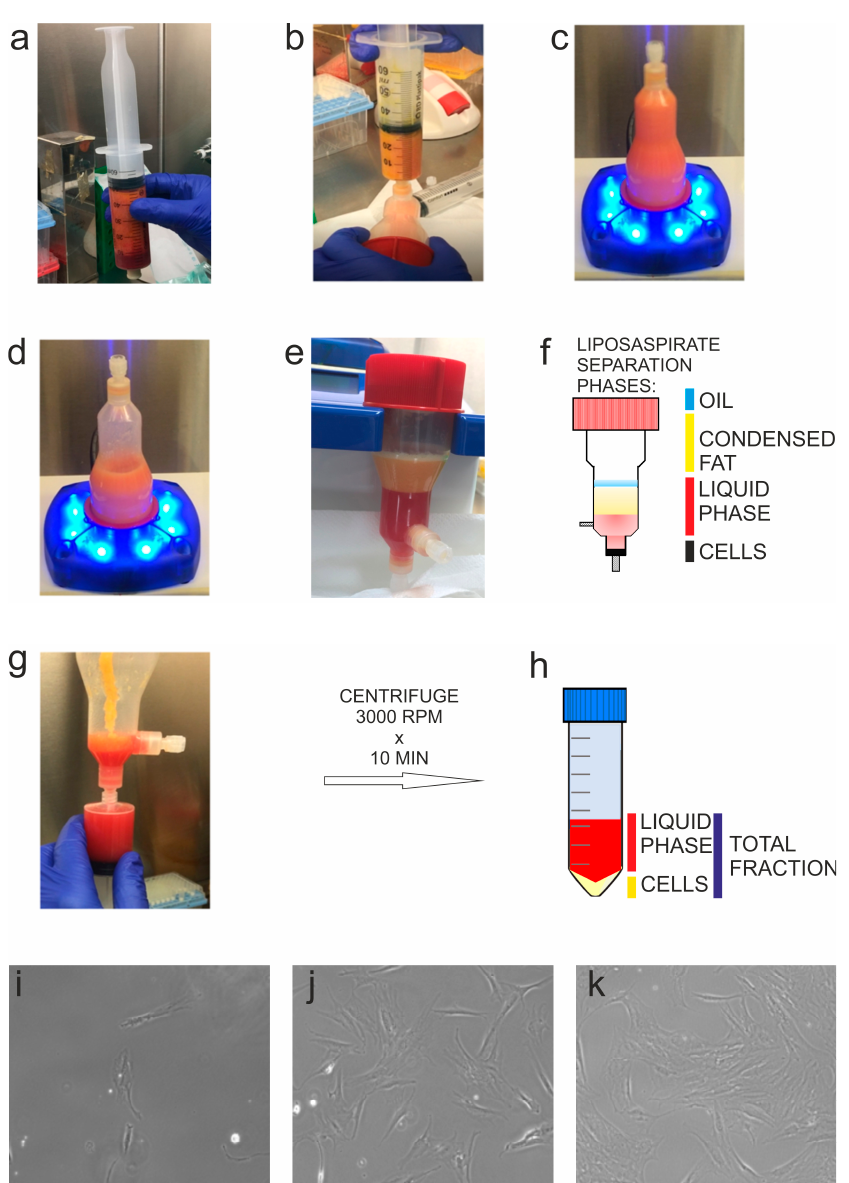
Figure 2. Lipoaspirate processing using IStemRewind. ( a – g ) Representative photographs of the different steps of the isolation procedure. The lipoaspirate sample, contained in a 50 mL sterile syringe ( a ), was injected into the IStemRewind tube ( b ) together with 20 mL of sterile saline solution. The IStemRewind tube with the sample was connected to the device and processed at 3000 rpm for 50 s ( c ), held for 10 s ( d ) and further processed for 20 s at 600 rpm. The IStemRewind tube was then positioned upside down for 15 min ( e ) to separate the different phases. ( f ) Picture of the different fractions isolated using IStemRewind, from top to bottom: oil, condensed fat, liquid phase (LP) and cells. ( g ) The total fraction (TF) composed of the LP and the cells was extracted from the IStemRewind tube with a sterile syringe and transferred to a 50 mL tube. ( h ) Picture of the appearance of the tube containing the TF after centrifugation. From top to bottom: LP and cells. ( i – k ) Representative bright field images of cells from the IStemRewind isolates seeded on plastic and kept in DMEM for 4 ( i ), 8 ( j ) and 16 days ( k ). Magnification: 40 ×